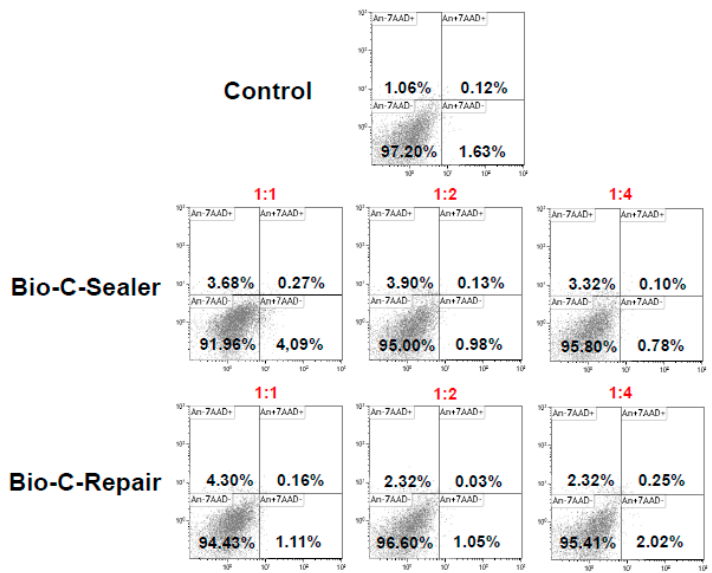
Figure 4. Cell survival in presence of bioactive cements (BECs) was performed by Annexin-V and 7-AAD double-staining. The data represent one of three independent experiments. (i) Lower left quadrant represents the viable cells; (ii) lower right quadrant shows the early apoptosis cells; (iii) upper right quadrant signifies the late apoptosis cells; and (iv) the upper left quadrant indicates dead cells.